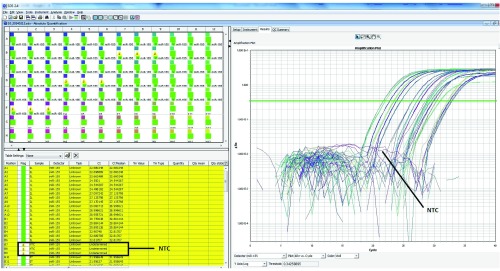
RT-qPCR amplification curves.There was no amplification observed in the no-template control (NTC) sample.